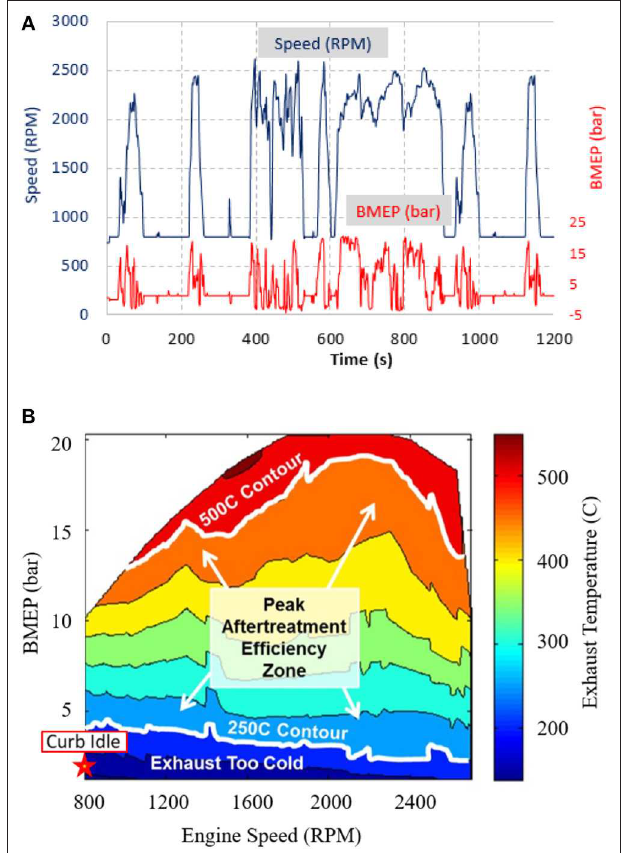
FIGURE 1 | (A) The speed (RPM) load (BMEP) space corresponding to the engine used in this effort during the HDFTP drive cycle. (B) Thermal contour regions for the engine in this study using its stock fuel-efficient calibration. Curb idle is represented by 800 RPM and 1.3 bar BMEP.